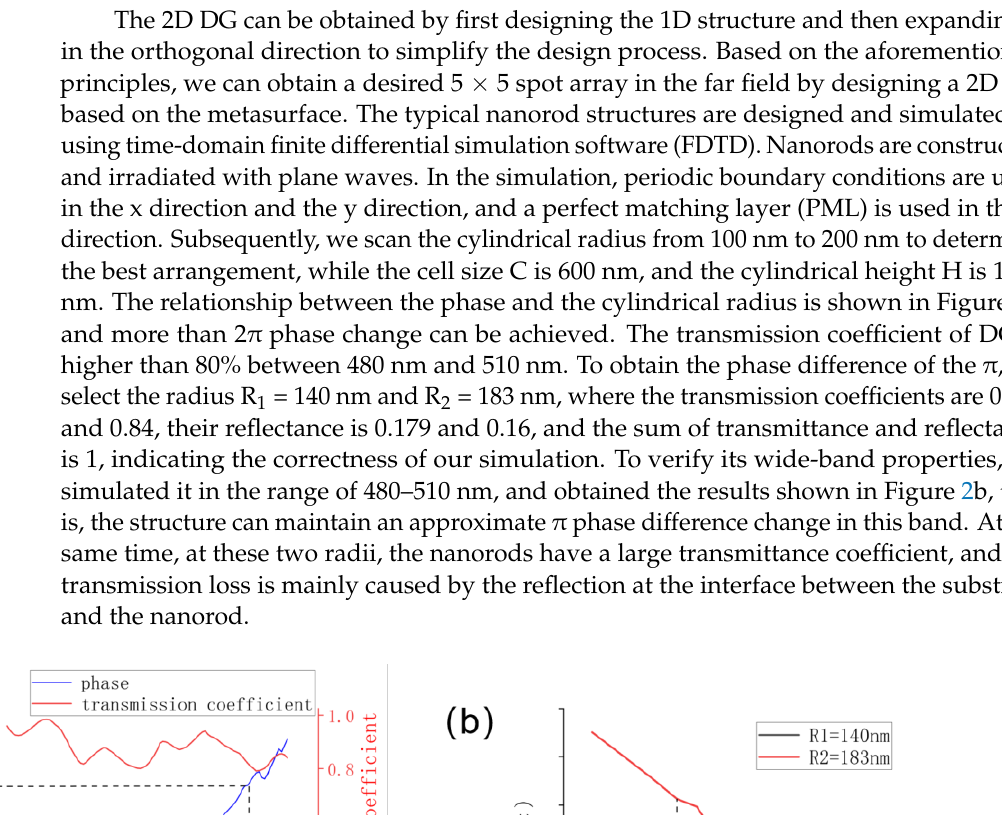
Figure 1. Transmittance distribution of a 1D DG.